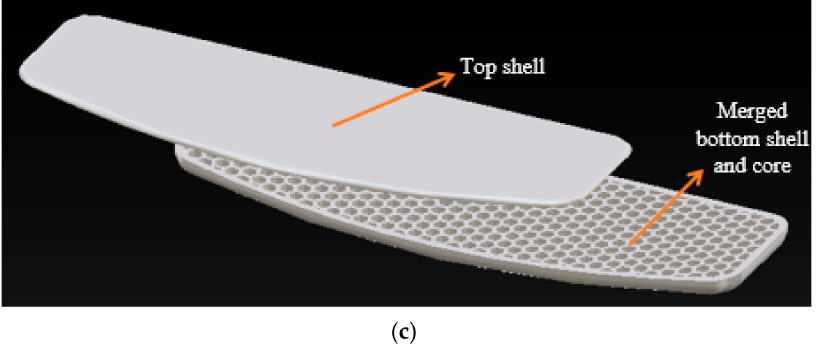
Figure 1. ( a ) A natural honeycomb structure; ( b ) the designed honeycomb core inspired by nature. ( c ) board components: the top shell, and the merged bottom shell and core.